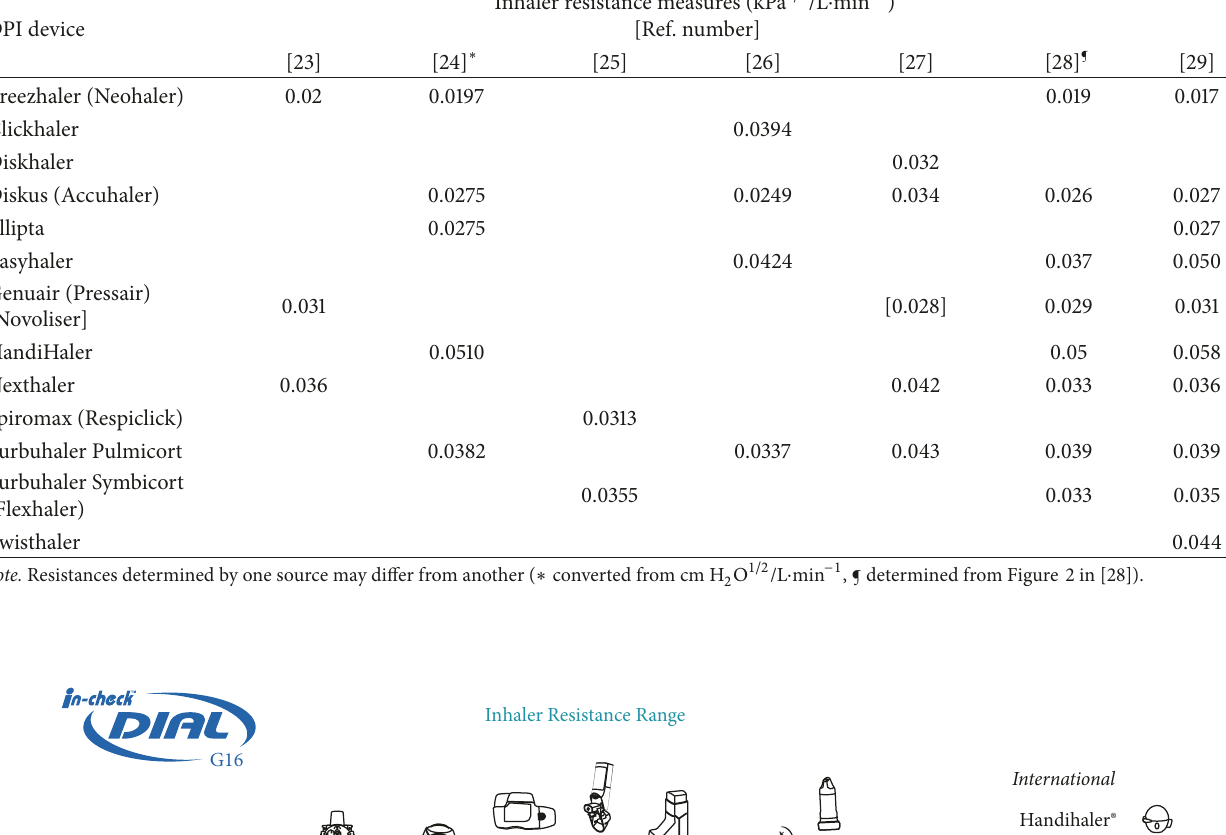
Table 2: Example third party dry powder inhaler resistance measures (kPa 1/2 /L ⋅ min −1 ). DPI device